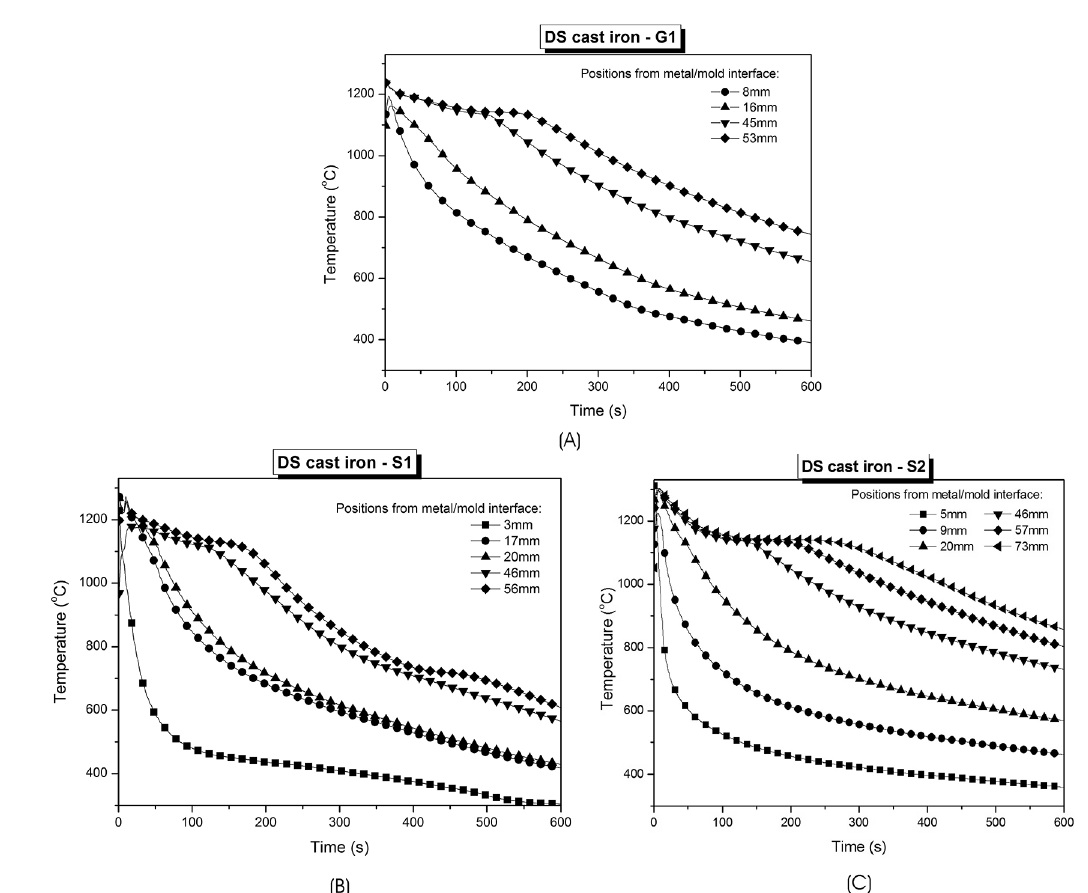
Figure 2: Experimental cooling curves obtained for different positions along the length of the DS cast iron castings: (a) G1: bottom part of the mold in graphite; ΔT~40K; (b) S1: bottom part of the mold in low carbon steel; ΔT~80K and (c) S2: bottom part of the mold in low carbon steel; ΔT=160K. ΔT is the maximum melt superheating level above eutectic temperature acquired by the first thermocouple near the cooled surface of the